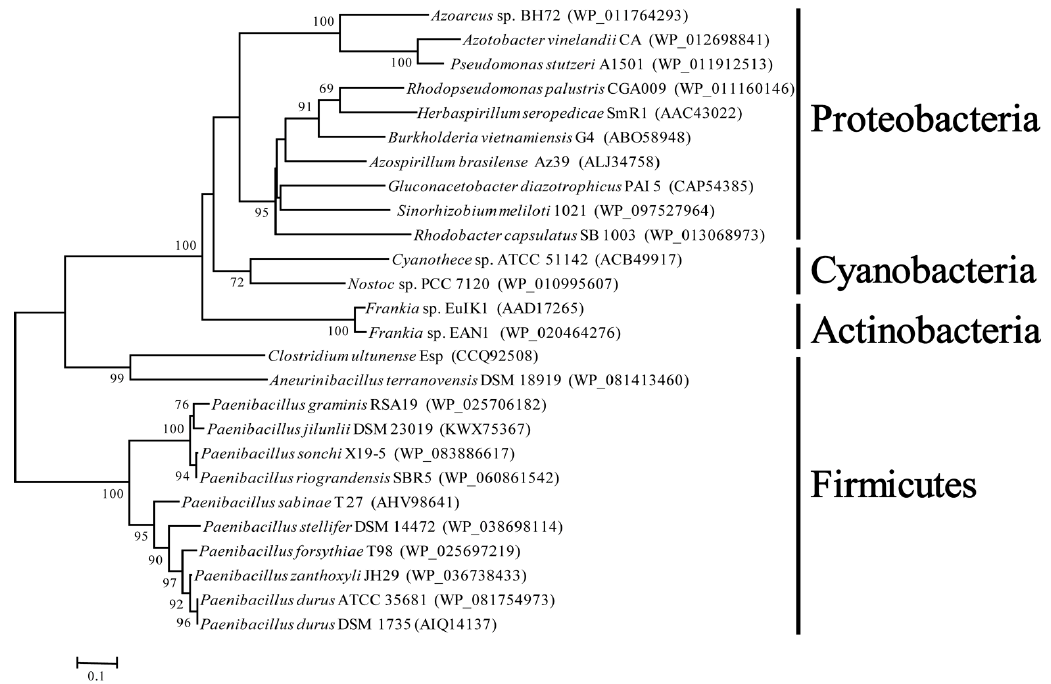
Figure 3. Neighbor-joining phylogenetic tree based on amino acid sequences of Orf1. Bootstrap analysis was performed with 1000 cycles. Only bootstrap values greater than 50% are shown at the branch points. Bar 0.1 substitutions per amino acid positions.